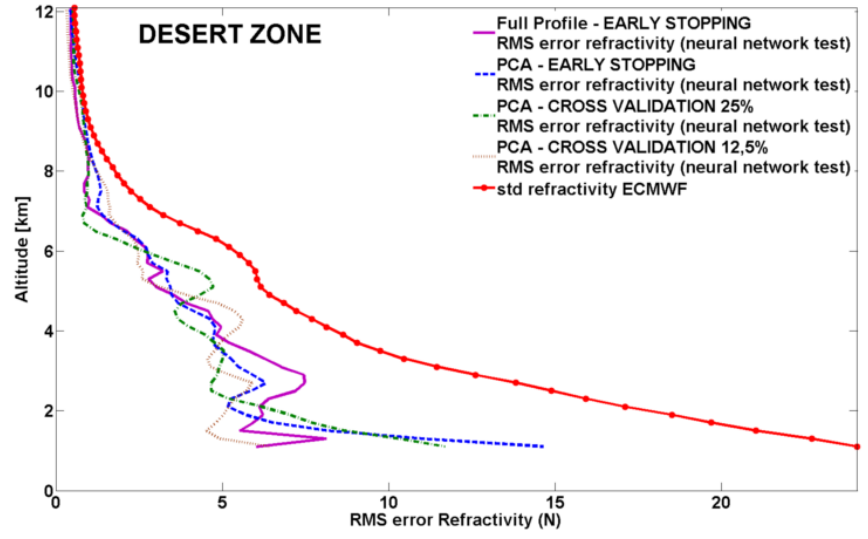
Figure 2. Desert zone, neural network independent test (10 occultations): RMS error profiles for N using the different neural network approaches.